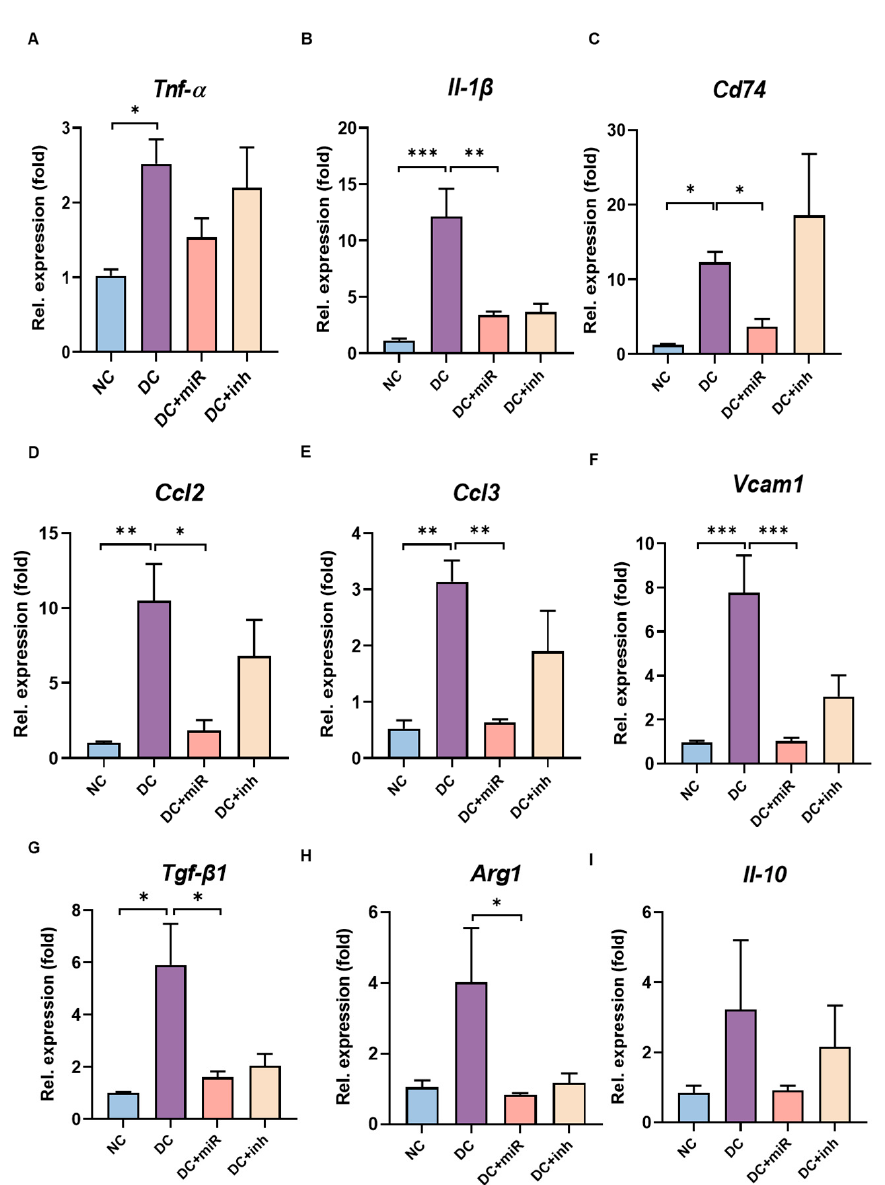
Figure 5. miR-124 inhibited the inflammatory molecules in diabetic retinae. The relative expression of inflammatory-associated genes evaluated by quantitative RT-PCR in the samples of rat retinae from groups of non-diabetic control (NC), diabetic control (DC), DC treated with miR-124 (DC+miR) or its inhibitor (DC+inh). ( A ) Tnf- α , ( B ) Il-1 β , ( C ) Cd74 , ( D ) Ccl2 , ( E ) Ccl3 , ( F ) Vcam1 , ( G ) Tgf- β 1 , ( H ) Arg1 , and ( I ) Il-10 . The expression of the housekeeping gene rat Gapdh was used as a control. Relative gene expression (fold versus Gapdh ) was calculated using ∆∆ CT method. Data are shown as mean ± SD, n = 5, * p < 0.05, ** p < 0.01, *** p < 0.001 (one-way ANOVA with Tukey’s multiple comparisons test).